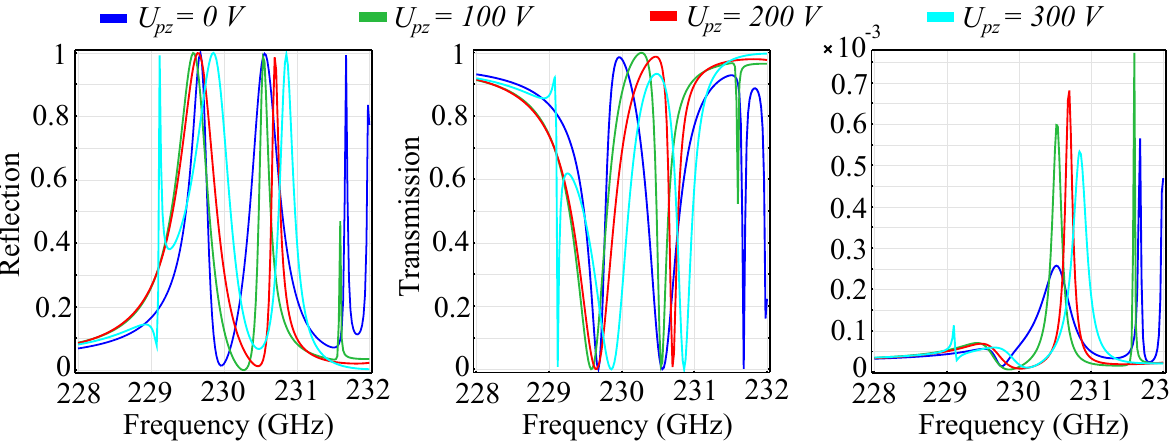
Figure 10. The reflected, transmitted, and absorbed waves for fixed values of the piezoelectric voltage applied longitudinally across the unit cell in the silica glass substrate unit cell configuration.